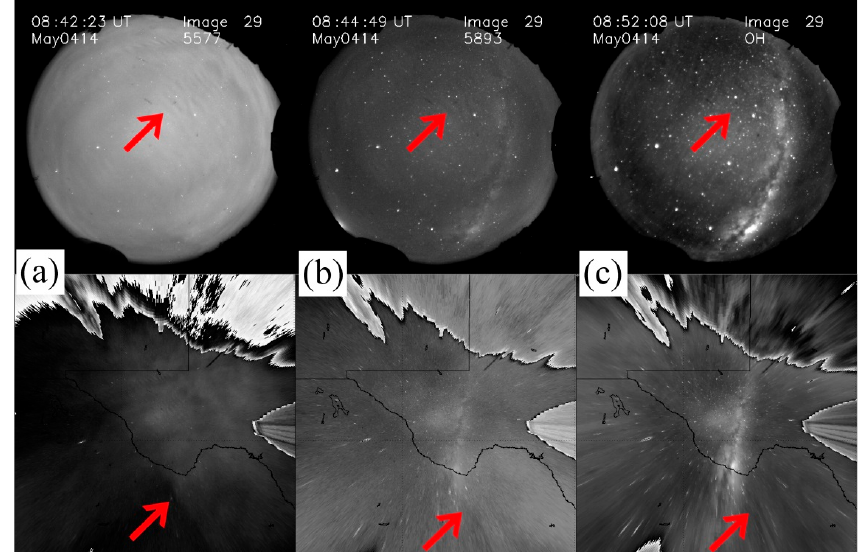
Figure 2. Three raw all-sky images from the McDonald Observatory (MDO) in ( a ) 557.7 nm (O( 1 S)), ( b ) 589.3 nm (Na) and ( c ) 695~950 nm (P 1 (6) doublet of OH(4-0) band) emission at ~08:45 on 4 May 2014 ( top ), and three corresponding unwrapped images ( bottom ). 2014 ( top ), and three corresponding unwrapped images ( bottom